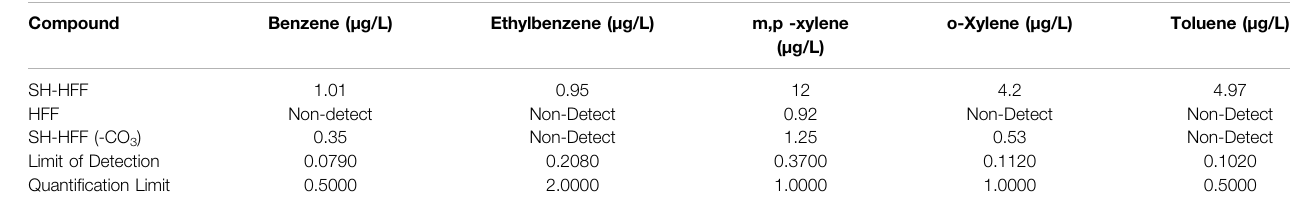
TABLE 4 | BTEX in solution from GC-MS analysis with detection and quanti fi cation limits.